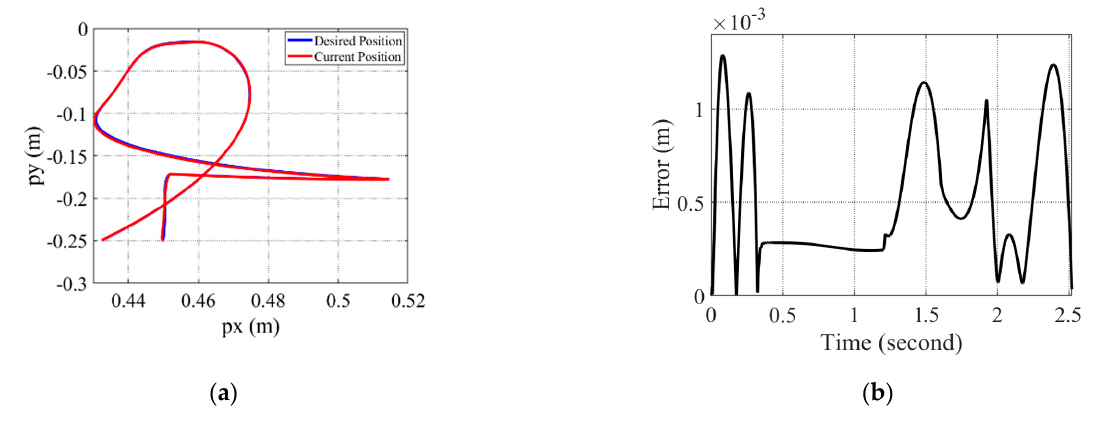
Figure 8. Position tracking errors of the joint actuators for a gait cycle.